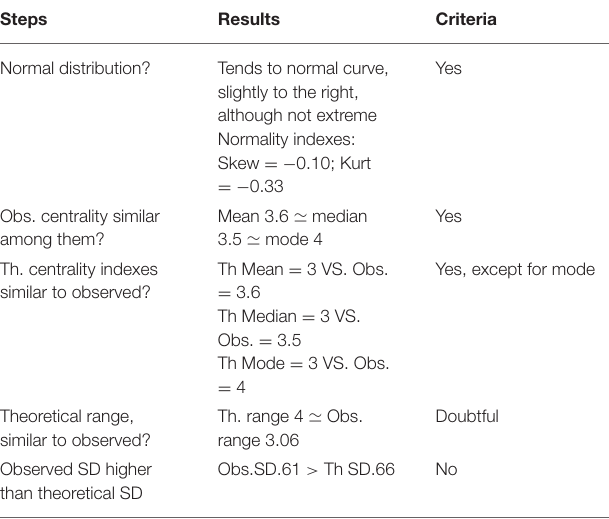
TABLE 3 | Global score sensitivity